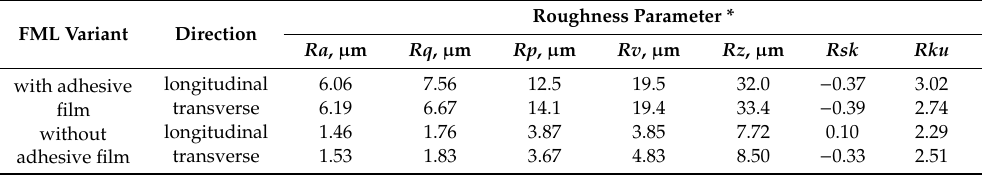
Table 5. Basic roughness parameters of fractured surfaces of the rigid